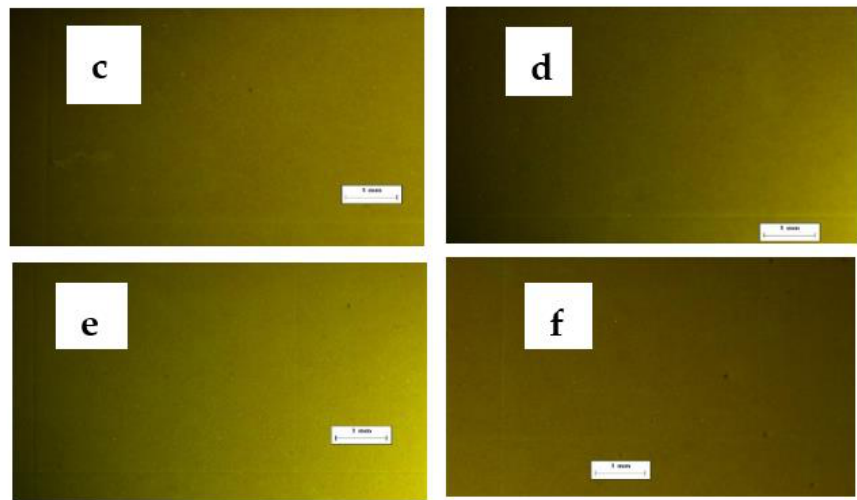
Figure 6. Compatibility with gypsum for commercial and Exp VPS (medium-bodied) impression materials under wet conditions, where (c) Elt M, (d) Exp-I, (e) Exp-II and (f) Exp-III. The scale bar is 1 Table 4. Compatibility with gypsum products for commercial and Exp VPS (medium bodied) im- pression materials under dry, moist and wet conditions.